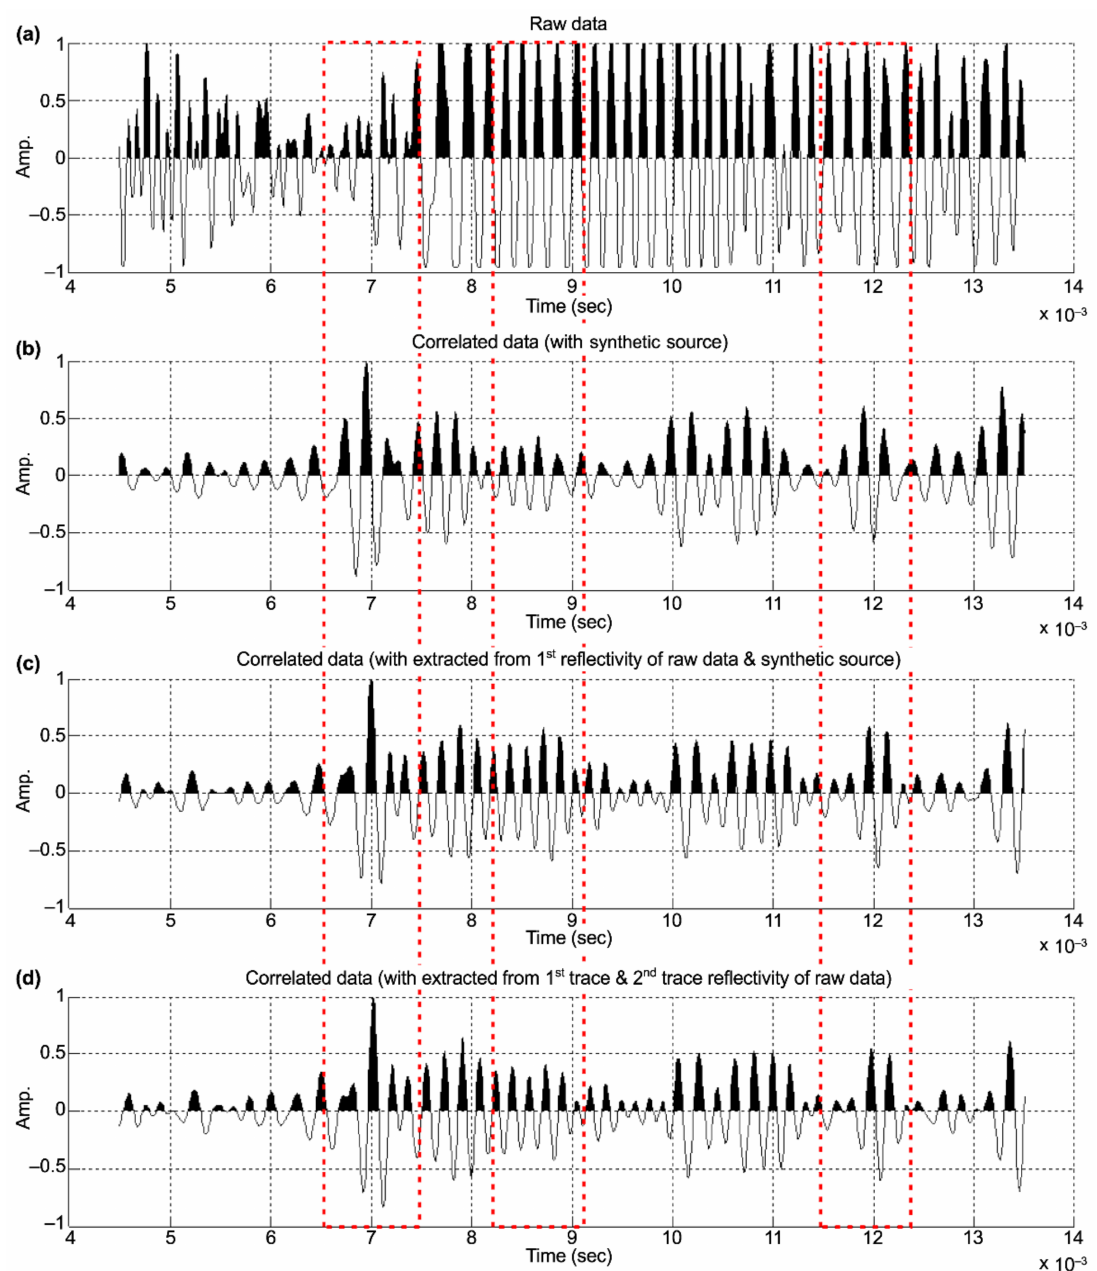
Figure 11. Comparison of Klauder wavelets. ( a ) Raw data 2, ( b ) correlated with 2–7 kHz ideal Chirp wavelet (Source I), ( c ) correlated with Source II, and ( d ) correlated with Source III. By correlating the signals and the entire section and representing the result as an envelope section, the images in locations (a), (b), and (c) show that the section acquired using Source II data (Figure 12) had a higher resolution and better continuity of the strata than the sections obtained using Source I (Figure 13) and Source III (Figure 14). Location (a) is a depression, and because Figures 13 and 14 show relatively higher amplitudes, the result appears in a blurred form, whereas Figure 12 displays the shape in